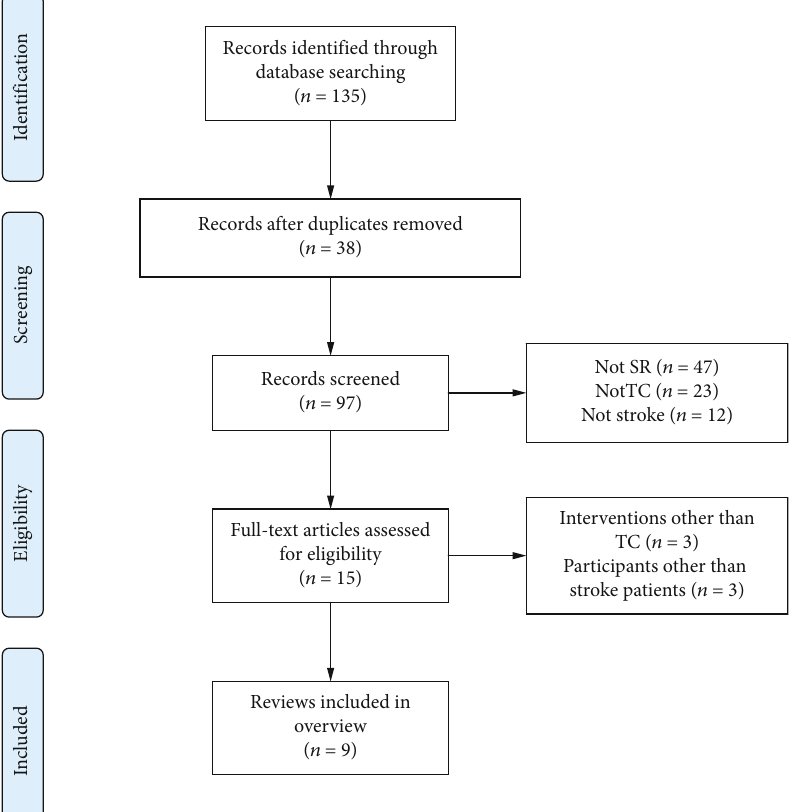
Figure 1: Literature selection